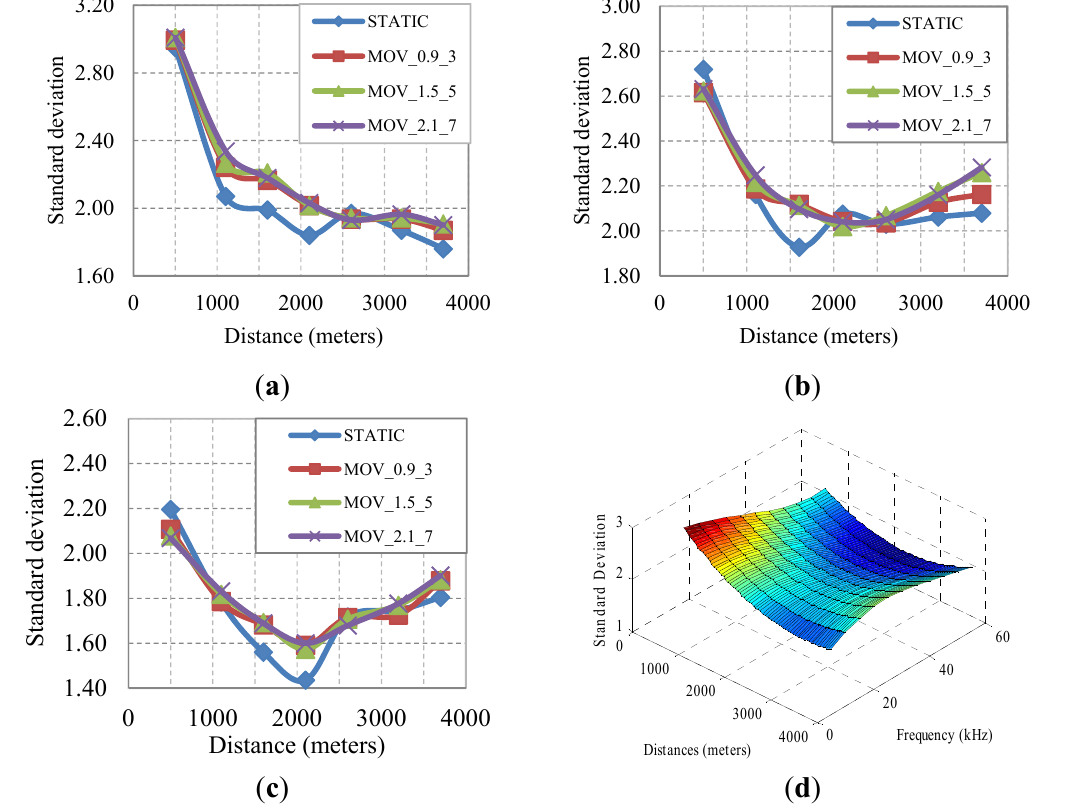
Figure 10. Standard deviation of attenuation vs. distance with different node movement approaches and frequency ranges. ( a ) 5–15 kHz, ( b ) 20–34 kHz, ( c ) 50–75 kHz, ( d ) Node movement 1,5 meters height, 5 meters